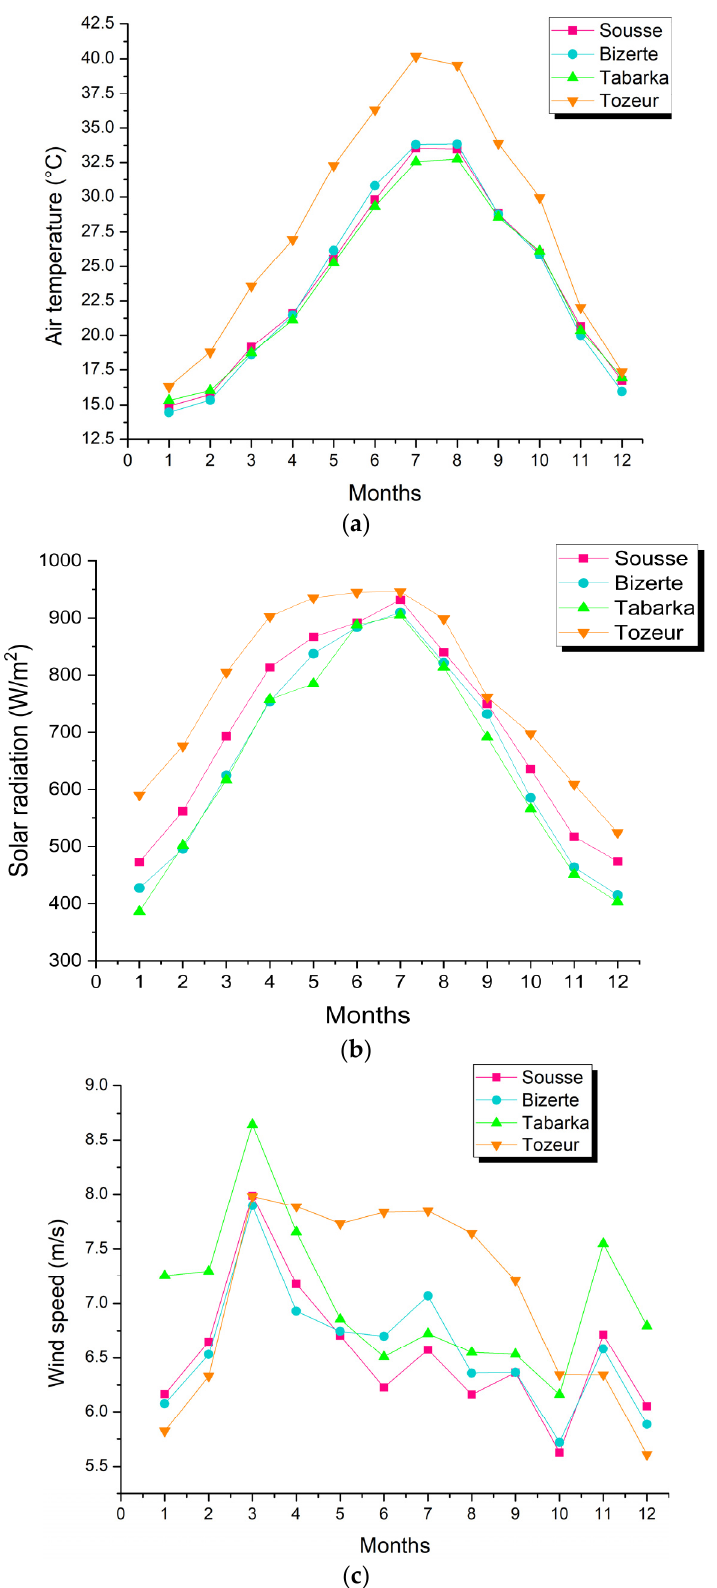
Figure 4. Climatic data ( a ) air temperature, ( b ) solar radiation, and ( c ) wind speed.